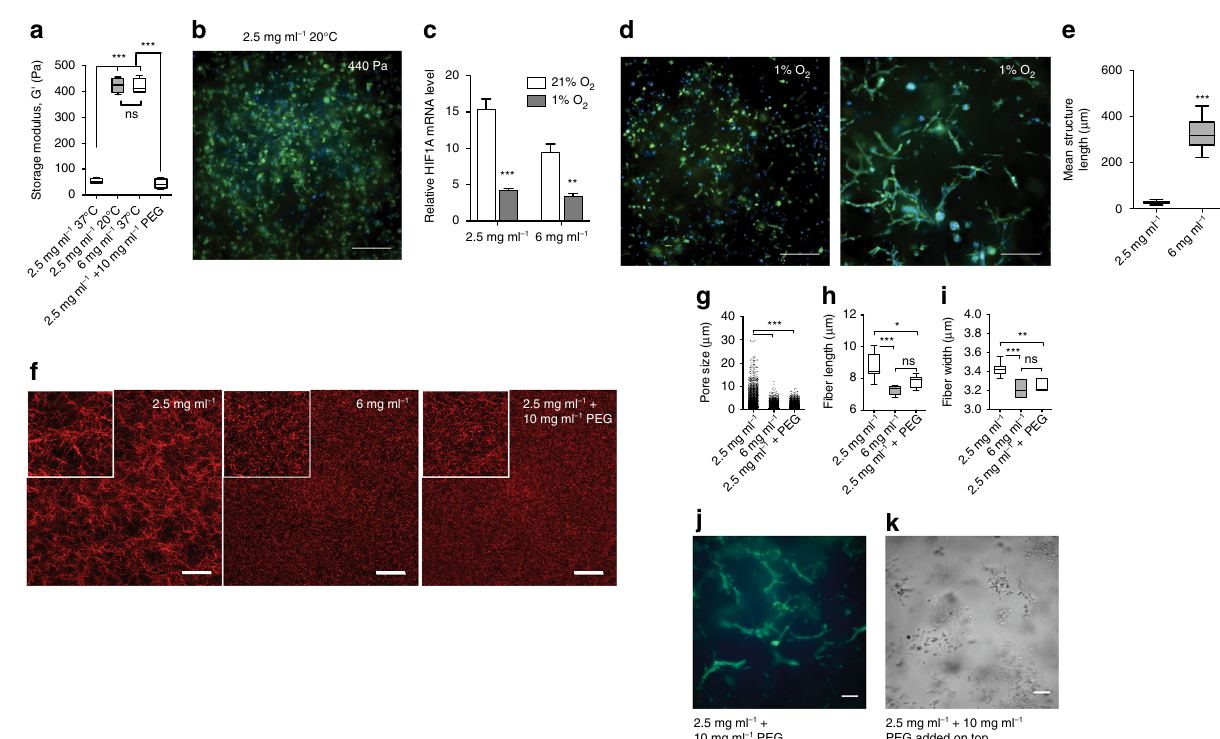
Fig. 3 Cell network formation is not triggered by hypoxia or matrix stiffness but rather by matrix architecture. a Storage modulus of collagen gels as estimated by shear rheology after polymerization at different temperatures. b Representative images of cells after 7 days of culture in low-density collagen polymerized at 20 °C (high stiffness, 440 Pa). c HIF1A expression in low-density and high-density 3D collagen after 7 days of culture under normoxic (21% O 2 ) or hypoxic (1% O 2 ) conditions. d Representative images of MDA-MB-231 cells in low-density and high-density 3D collagen after 7 days of culture under hypoxic (1% O 2 ) conditions, scale bar 250 μ m. e Quanti fi cation of mean structure length after 7 days of culture under hypoxic (1% O 2 ) conditions in low-density and high-density collagen. f Confocal re fl ection images of collagen fi bers in 3D matrices. Left: 2.5 mg ml − 1 collagen I, center: 6 mg ml − 1 collagen I, and right: 2.5 mg ml − 1 collagen + 10 mg ml − 1 PEG. Insert shows a ×2 zoom. Scale bar 100 μ m. g Quanti fi cation of pore size in the three conditions showed in f . h Fiber length and i fi ber width as measured from the confocal re fl ection images in the three conditions showed in f . j Representative image of MDA- MB-231 cells cultured for 7 days in a 2.5 mg ml − 1 collagen + 10 mg ml − 1 PEG 3D matrix. Cells are stained with Alexa-488 Phalloidin (F-Actin) and DAPI (nuclei). Scale bar 250 µ m. k Representative bright fi eld image of MDA-MB-231 breast cancer cells cultured in a 2.5 mg ml − 1 collagen matrix where 10 mg ml − 1 PEG was added to the media after polymerization. Scale bar 125 μ m. Bar graphs represent mean ± s.d. and data in box and whiskers plots is presented using Tukey method. n = 3 biological replicates for all experiments unless otherwise noted. Statistical signi fi cance was determined by ANOVA ( a , c , g – i ) and Mann – Whitney U test ( e ) and is indicated as *, **, *** for p ≤ 0.05, p ≤ 0.01, p ≤ 0.001, respectively. Bars plots are mean ± as drivers of metastasis correlating with VM 18 and with brain metastases of lung and breast cancers 26 .